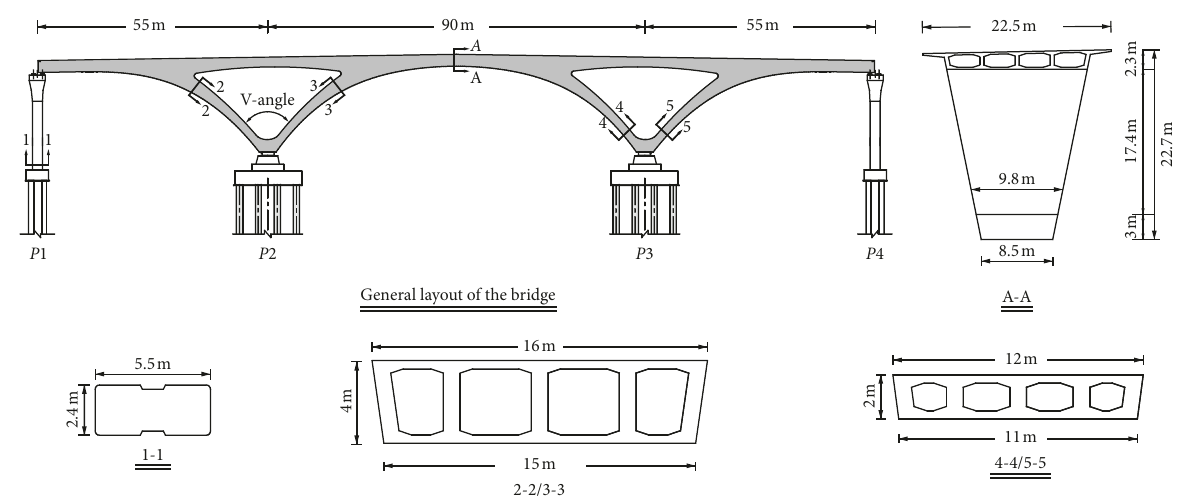
Figure 3: Configuration of the three-span V-shaped continuous girder